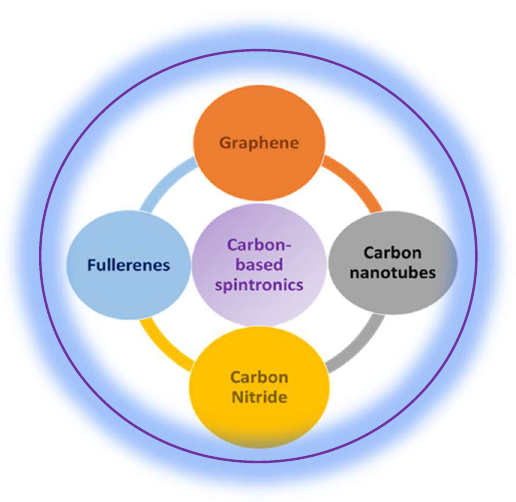
Figure 1. Schematic representation of carbon-based spintronics.